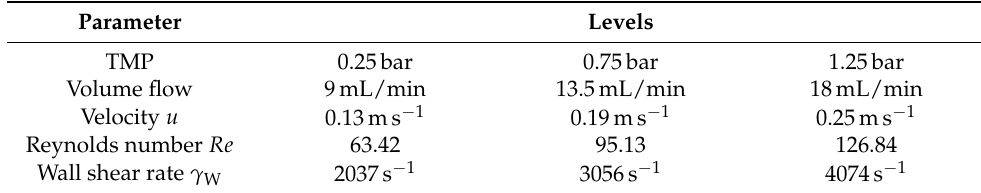
Table 1. Hydrodynamic parameter of the